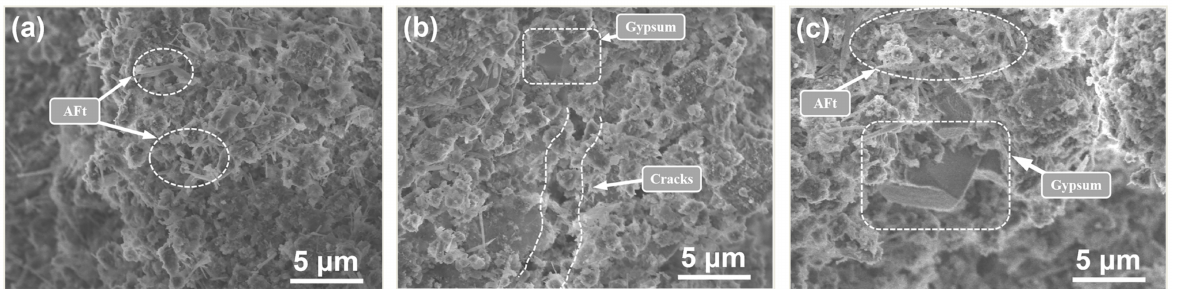
Figure 12. SEM showing erosion produced after the 12th cycle with different concentrations: ( a ) water (DN0); ( b ) 5% Na 2 SO 4 solution (DN5); ( c ) 10% Na 2 SO 4 solution